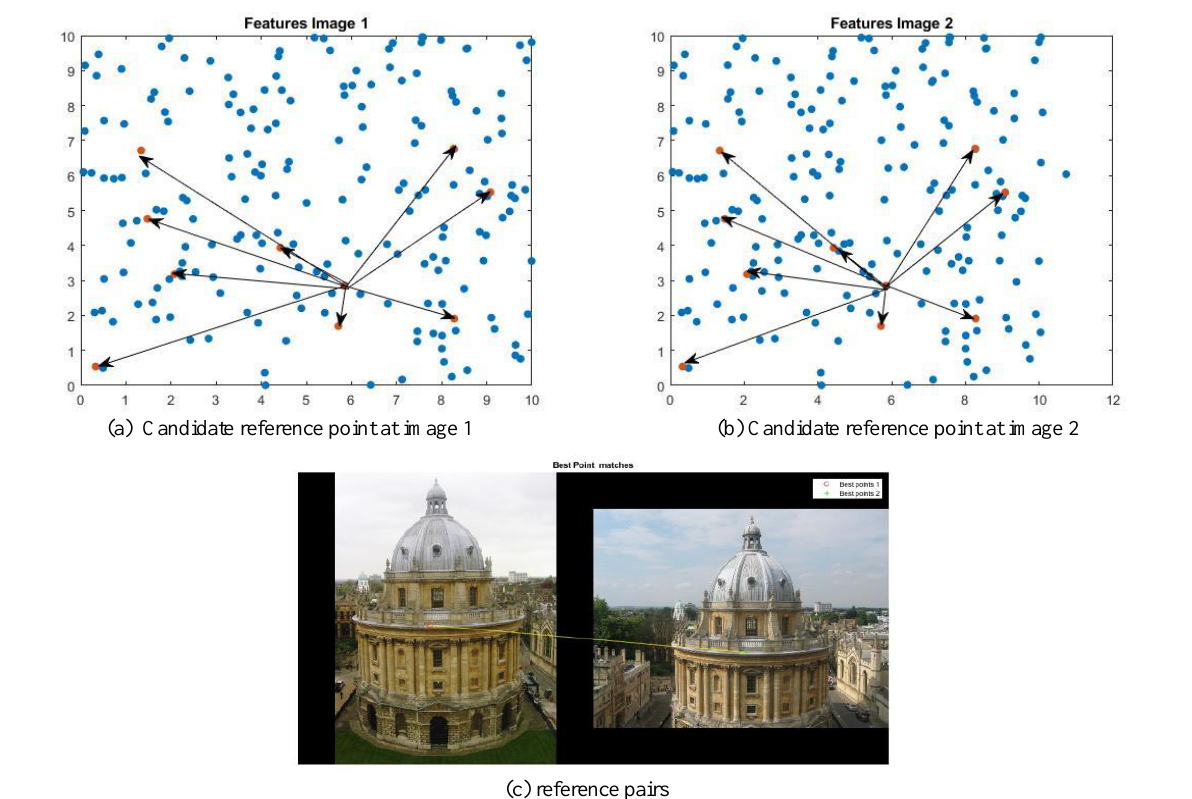
Figure 5: ( a) Candidate reference point at image 1 (b) Candidate reference point at image 2 (c) shows the reference pairs. To start